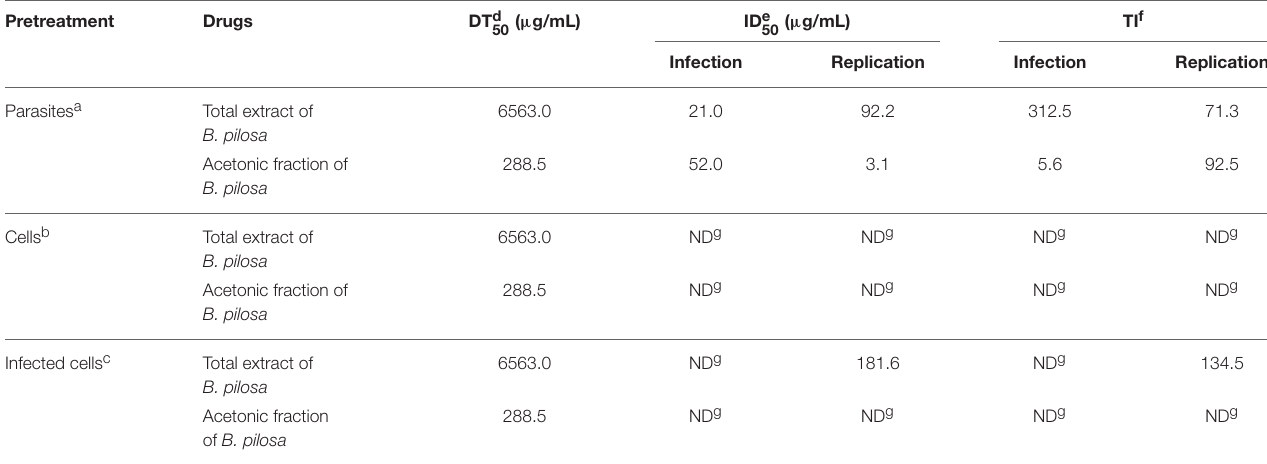
TABLE 1 | Effects of Bidens pilosa total extract or acetonic fraction treatments on infection and intracellular replication of Toxoplasma gondii in HeLa cells under different conditions. Pretreatment Drugs DT d 50 ( µ g/mL) ID e 50 ( µ g/mL) TI f Infection Replication Infection Replication Parasites a Total extract of B. pilosa